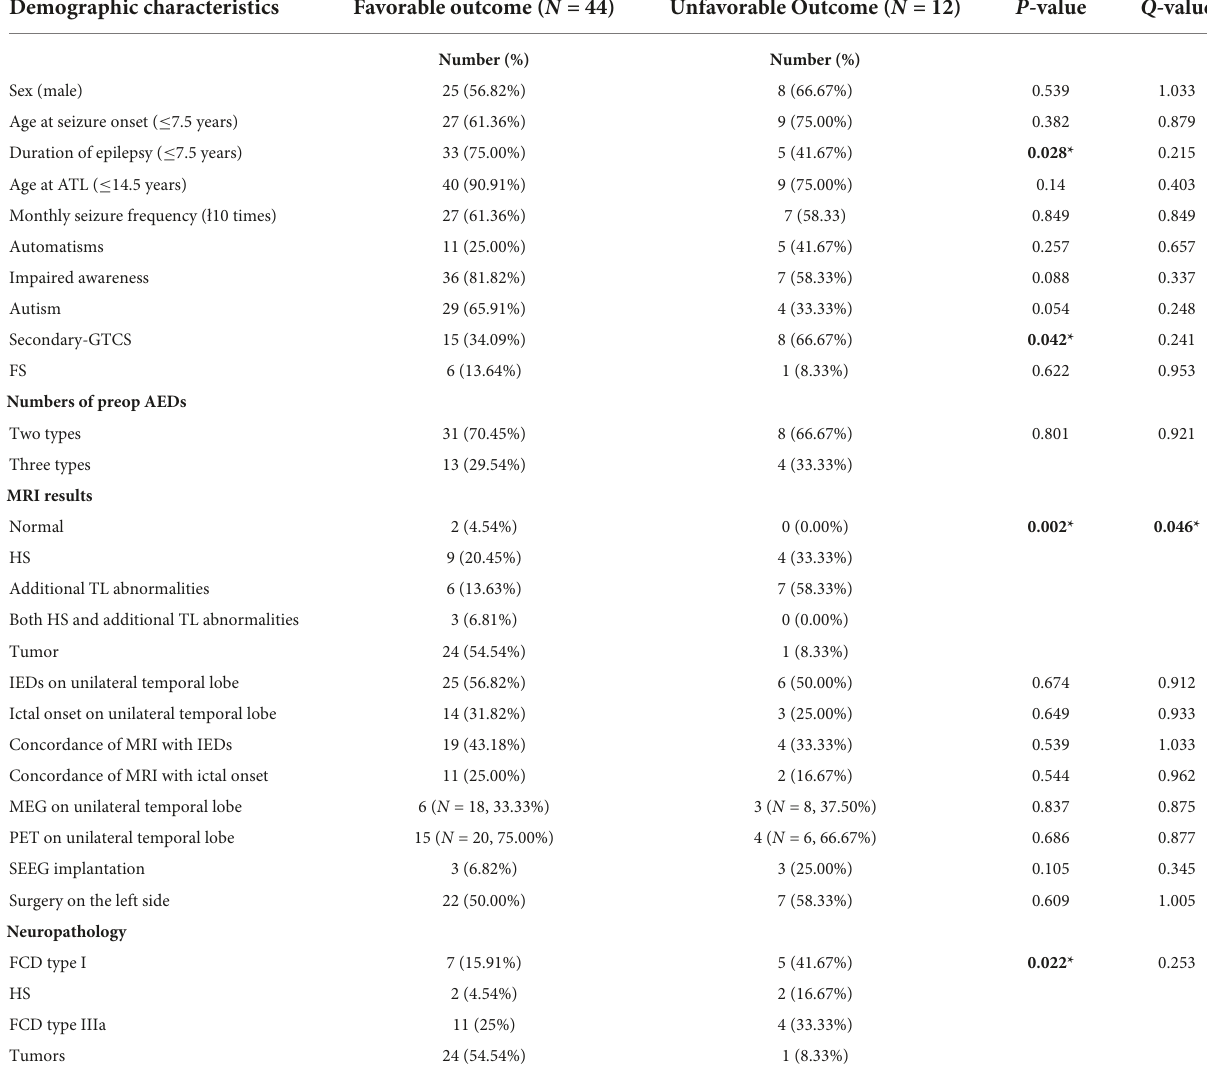
TABLE 2 Children’s demographic characteristics and their relationship with seizure outcomes. Demographic